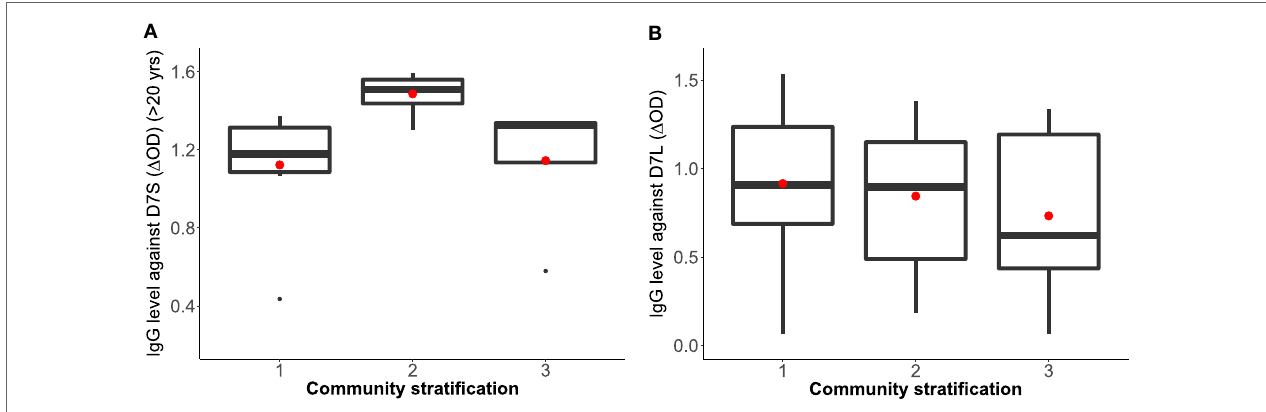
FigUre 3 | Correlation analysis between Aedes aegypti D7 short (a) and D7 long (B) salivary proteins and living conditions represented as socioeconomic stratification. Stratum 1: lower-low conditions (D7S n = 8, D7L n = 23), stratum 2: low conditions (D7S n = 8, D7L n = 26), and stratum 3: upper-low conditions (D7S n = 4, D7L n = 12). Notice that D7S graphic excludes participants under 20 years old in the analysis.